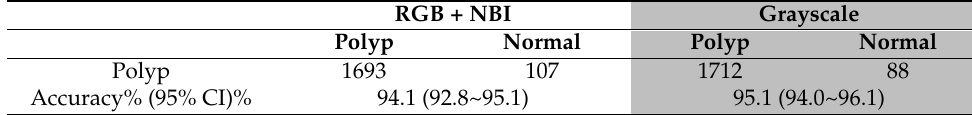
Table 10. CGMH-WL + CGMH-NBI testing dataset of polyp